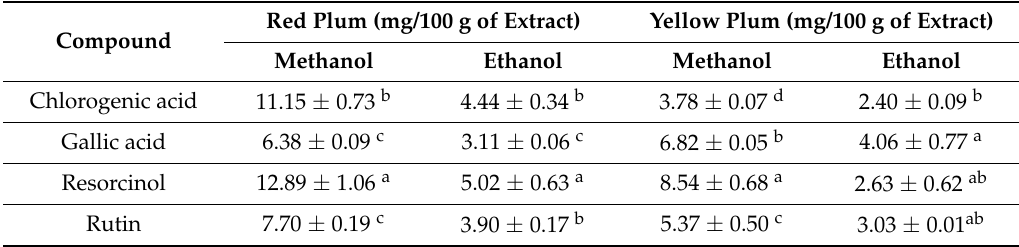
Table 1. Quantification of phenolic compounds in the extracts of the edible parts of red and yellow plum using two different solvents by